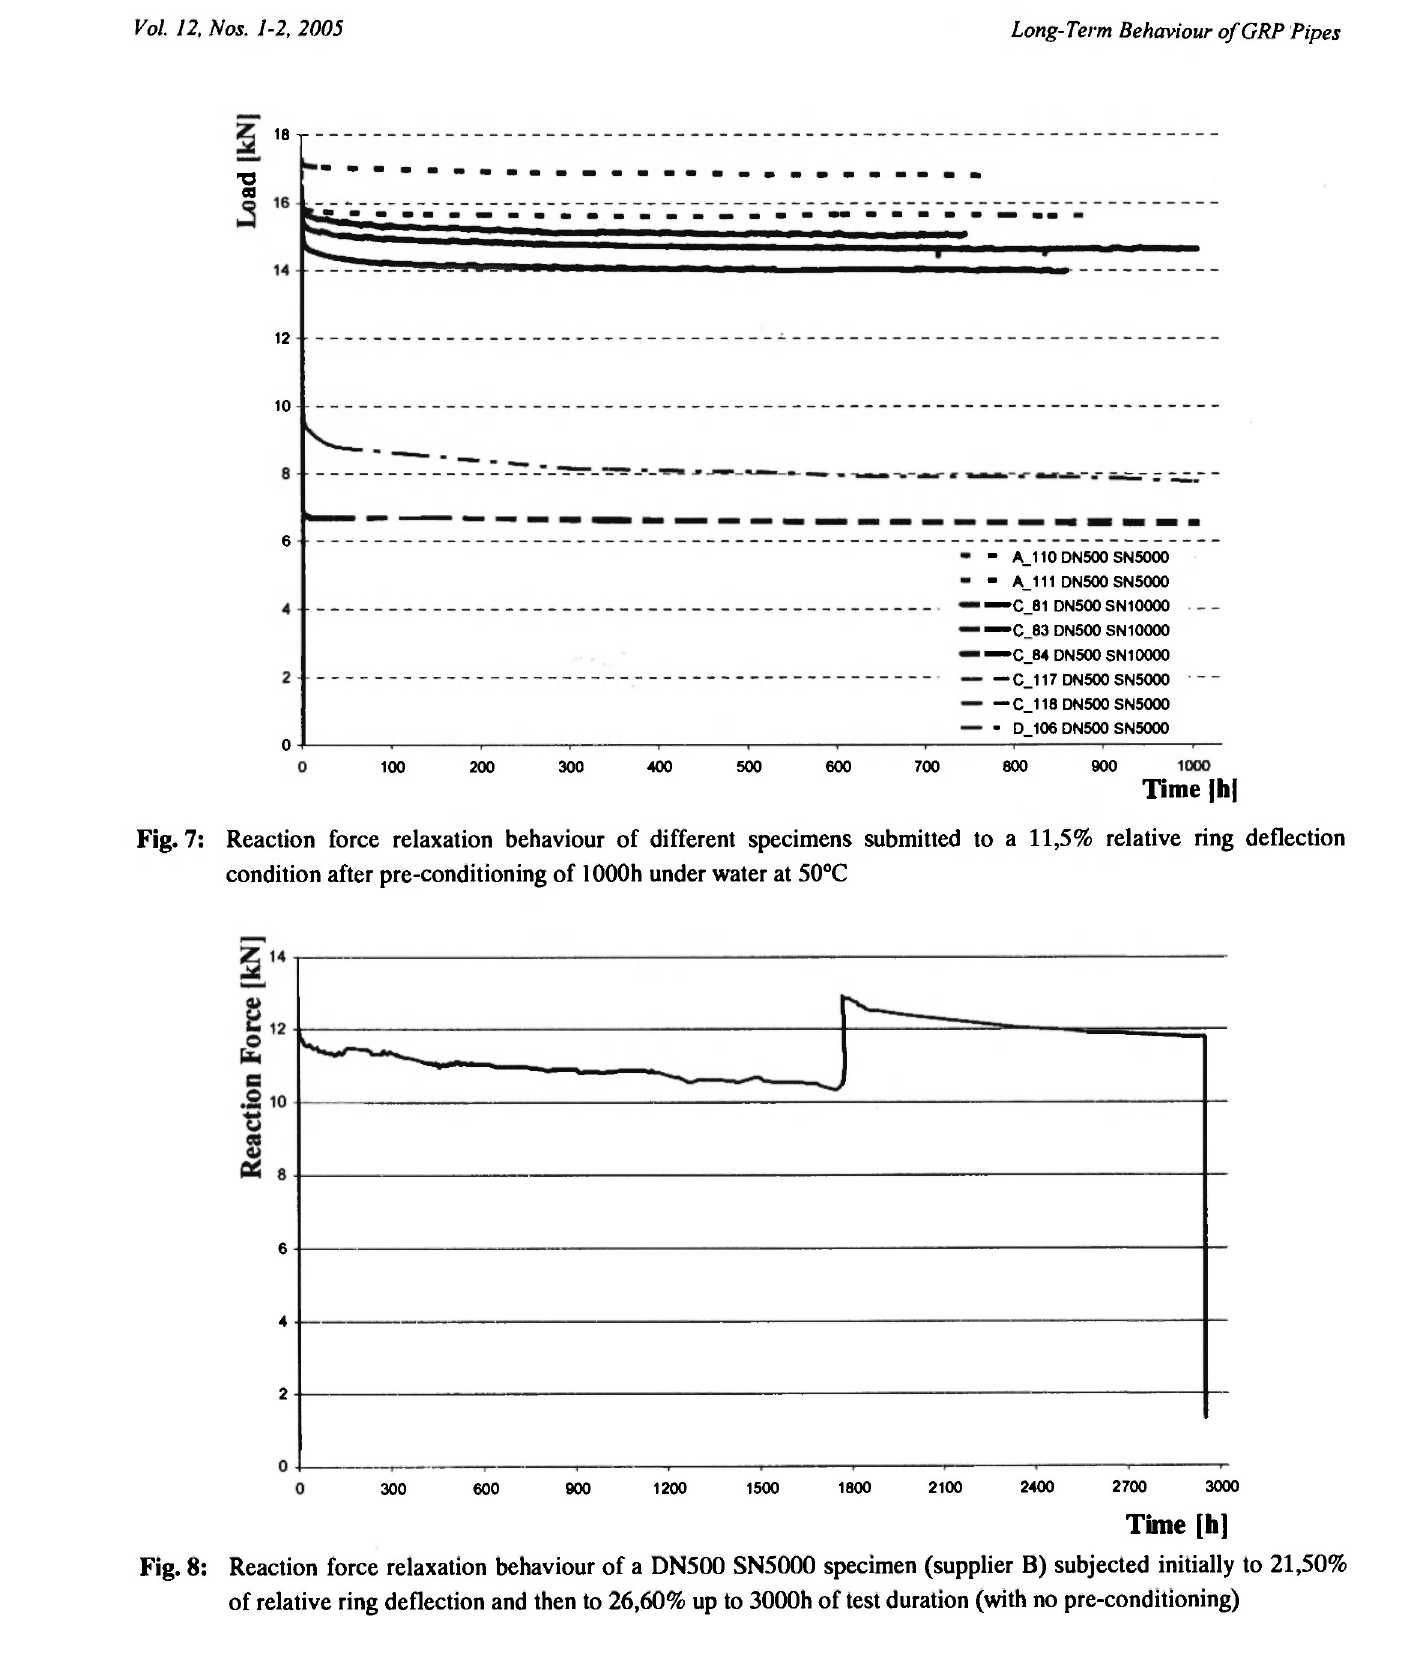
Fig. 8: Reaction force relaxation behaviour of a DN500 SN5000 specimen (supplier B) subjected initially to 21,50% of relative ring deflection and then to 26,60% up to 3000h of test duration (with no